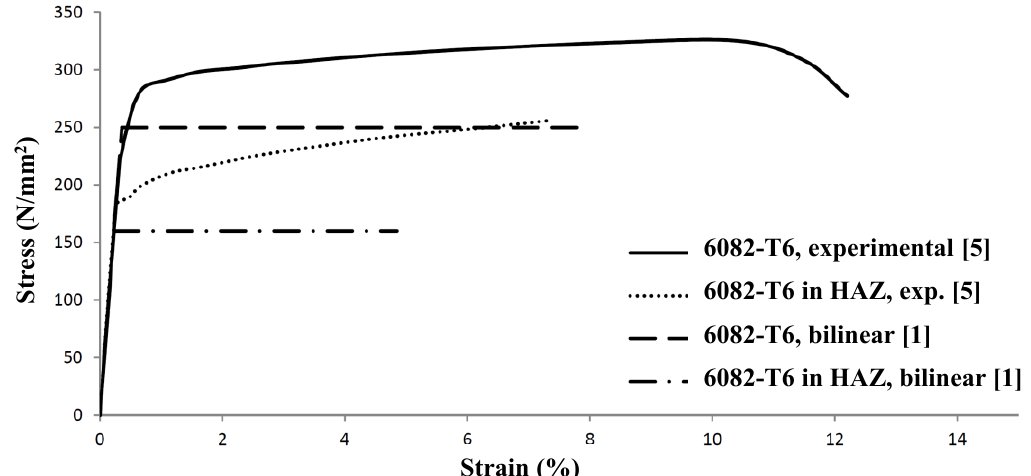
Figure 17. Stress-strain diagram of aluminum alloy 6082-T6.